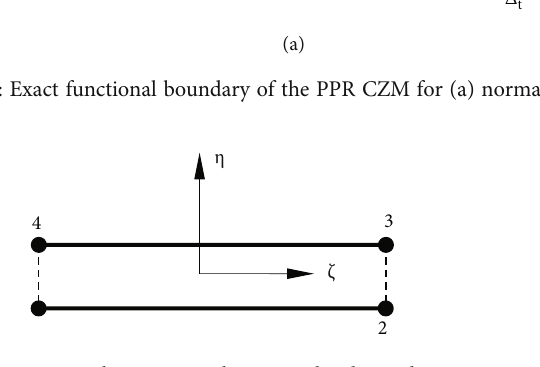
Figure 4: 2D cohesive zone element in local coordinates.